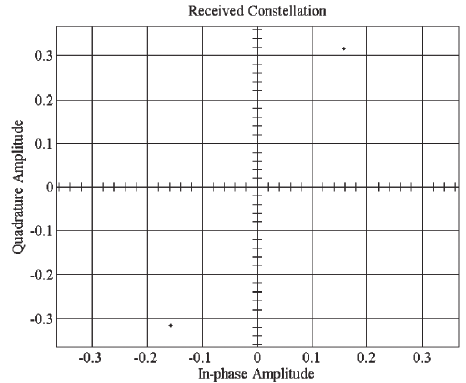
Fig. 5. End signal constellation for BPSK modulation scheme for phase offset 20 o in the uplink and the downlink: with convolutional coding (rate ¾, constraint length K = 7); noise temperatures of satellite and ground receivers at 0 K; free space path loss of 157 dB; HPAs backoff level at 7 dB; frequency offset is equal to zero; d 1 = d 2 = d 3 = d 4 = 1.0 m; satellite transponder phase noise is negligible